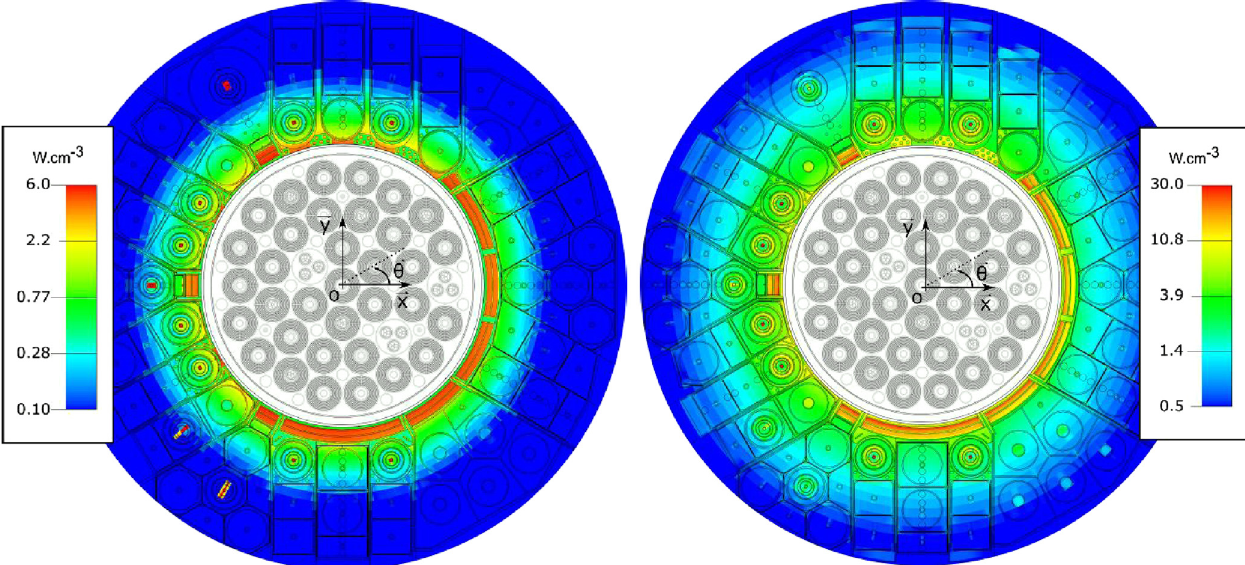
Fig. 5. Neutron heating on the left and gamma heating on the right. The values are taken in the axial center of the core, integrated axially over 5 cm. Neutron heating in re fl ector is, by an average factor 5, lower than gamma heating (different color scale).